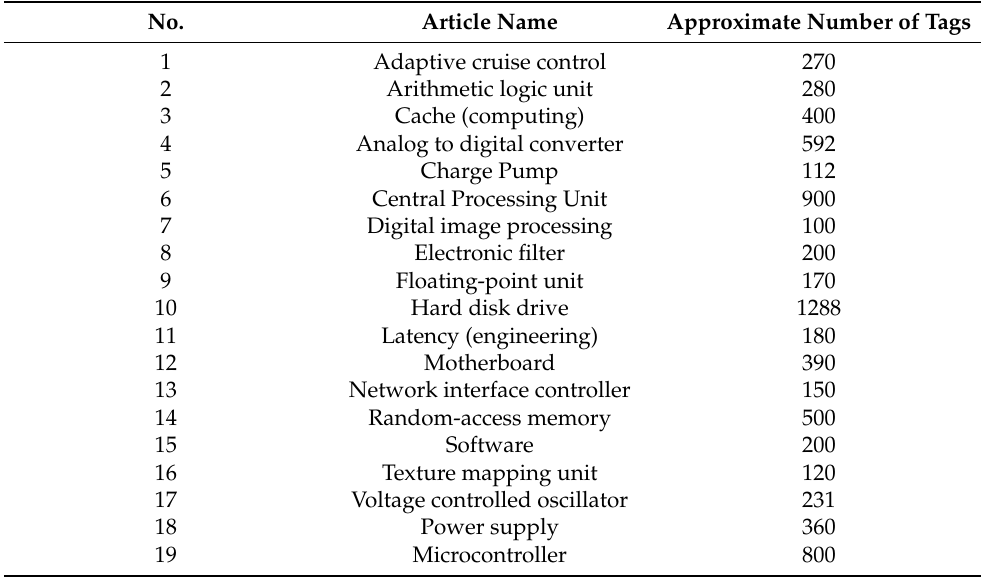
Table 4. List of Wikipedia articles and the number of labeled